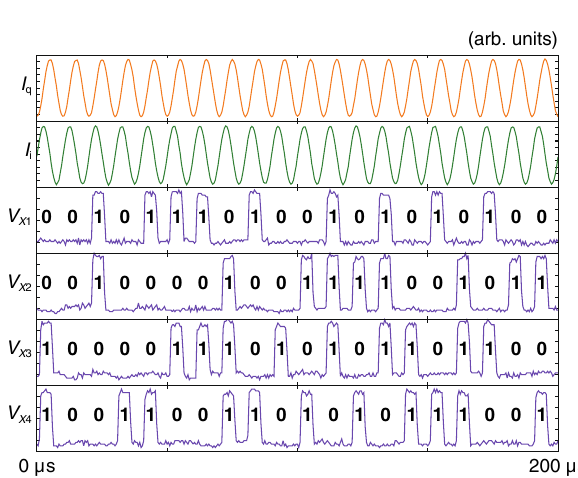
Figure 5. Micrograph of the AQFP-based XSR circuit for n = 4, which corresponds to the circuit shown in Fig. 3a. The circuit was fabricated using the HSTP.